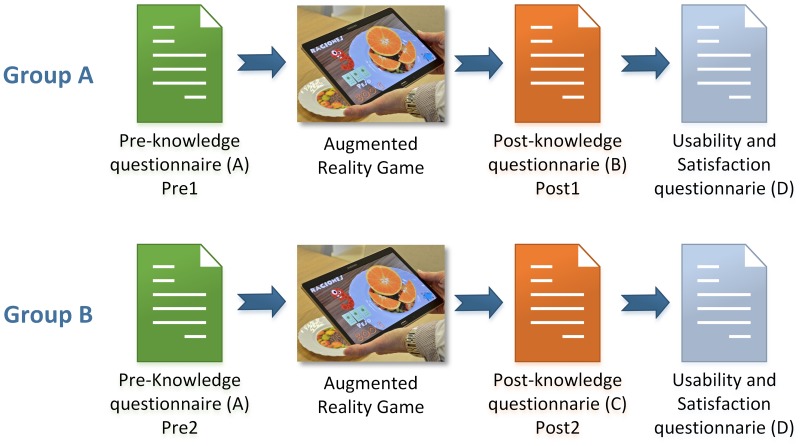
Study procedure.